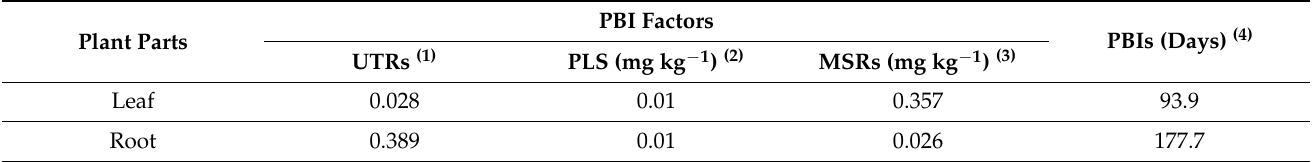
Table 6. Plant-back intervals of diazinon for rotational cultivation of